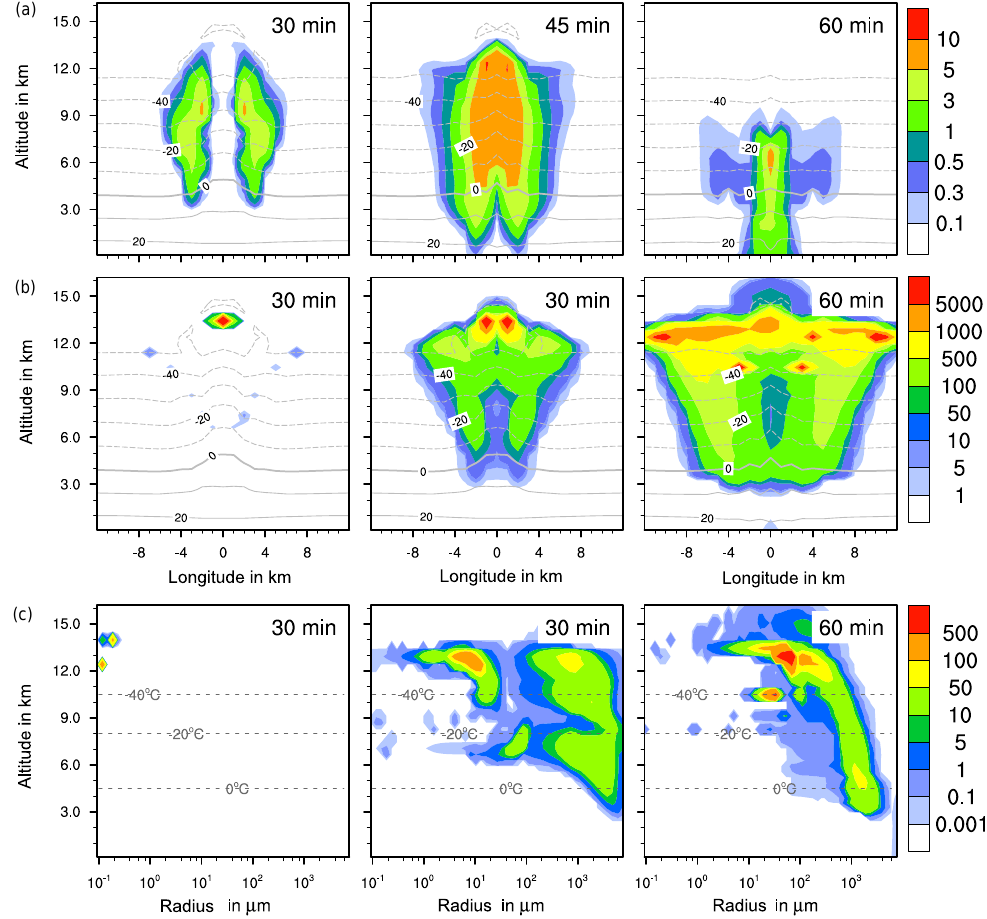
Figure 7. Ice formation from deposition nucleation with 10% feldspar. (a, b) Temporal development of two parameters shown in a vertical cut through the cloud center. Horizontal dashed lines: temperature in ◦ C. (a) Ice water contents in gkg − 1 and (b) ice particle numbers per m 3 . (c) Ice particle size spectra in the center cell of the cloud at different times. Number concentrations per m 3 . Left pictures in (b) and (c) show primary deposition freezing